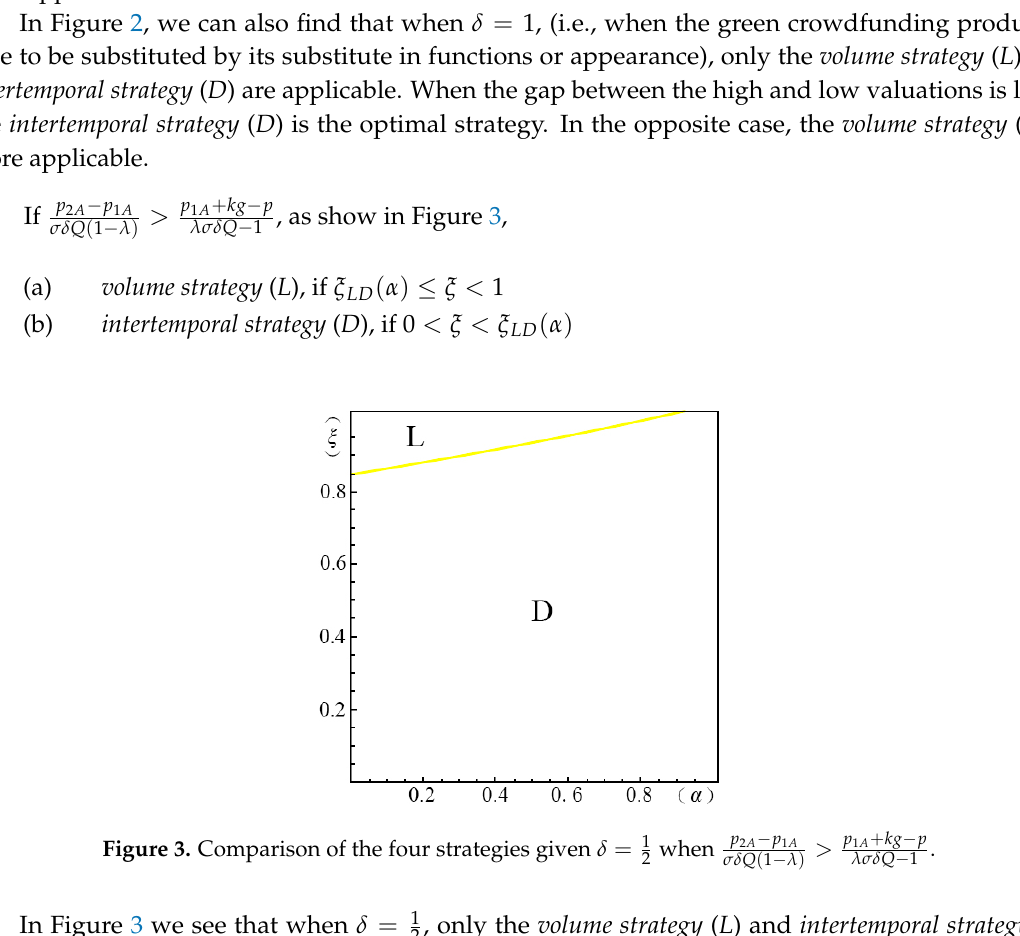
Figure 2. Comparison of the four strategies given (cid:2012) (cid:3404) 1 when (cid:3043) (cid:3118)(cid:3250) (cid:2879)(cid:3043) (cid:3117)(cid:3250)